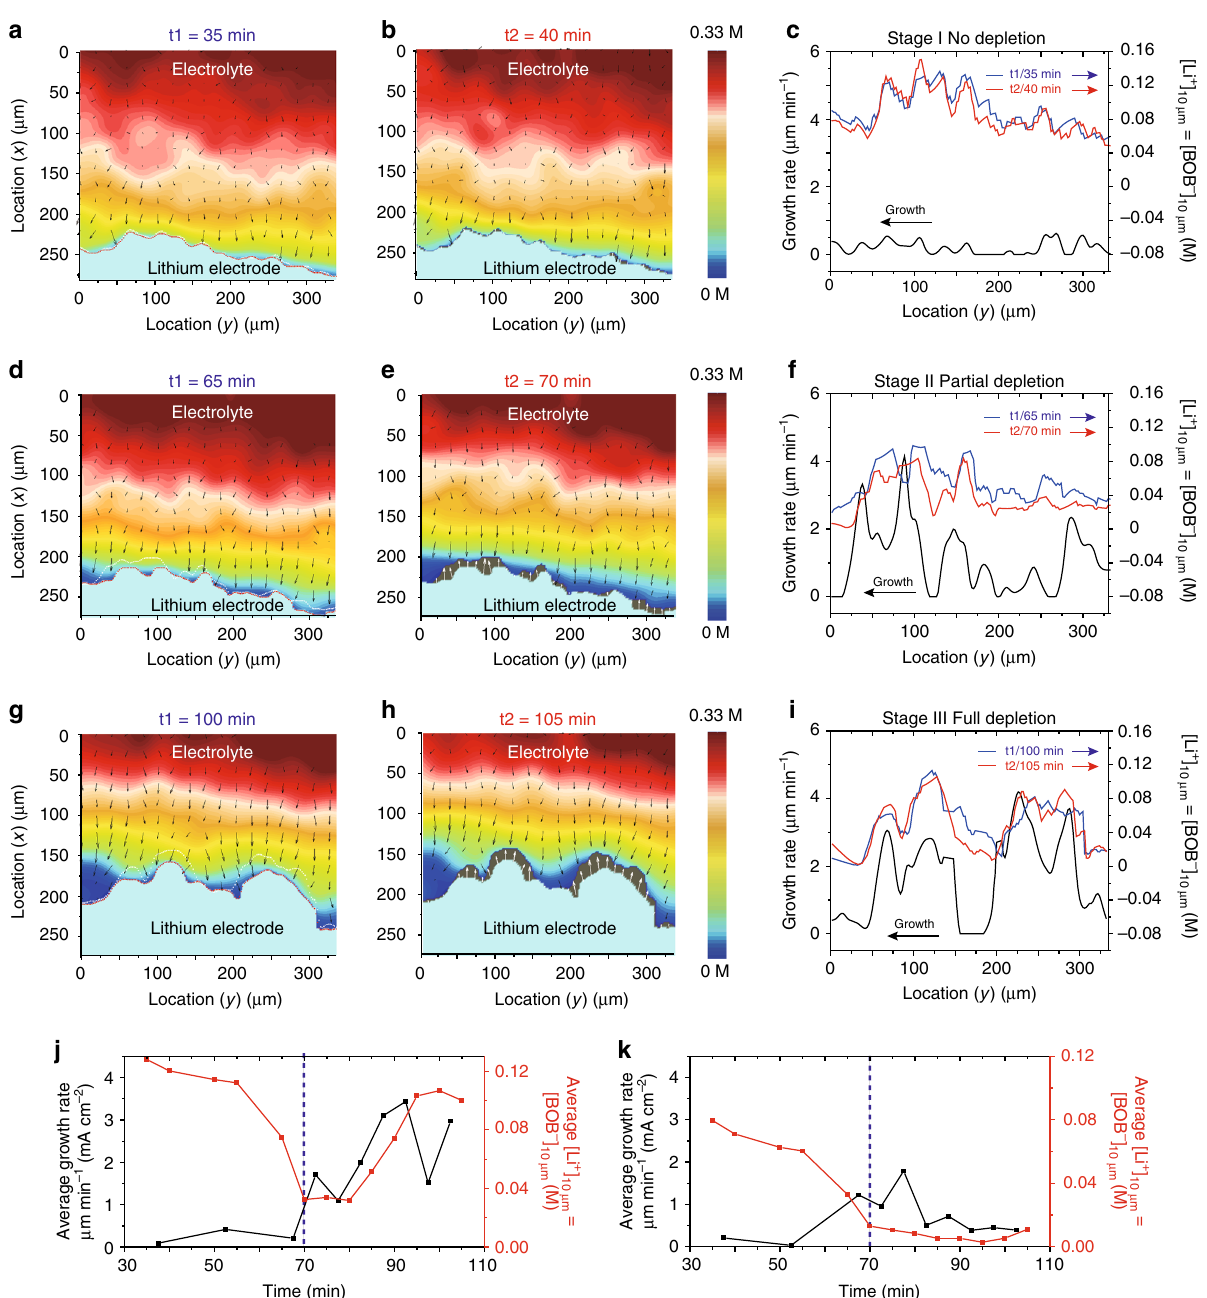
Fig. 4 Correlation between local Li growth and local Li + concentration. 2D overlapping images at three representative moments (t1/t2), a – c 35/40 min (stage I / no depletion), d – f 65/70 min (stage II / partial depletion), and g – i 100/105min (stage III / full depletion). The fi rst column exhibits the ionic concentration pro fi le and solid Li electrode region at t1. The boundaries of the lithium electrode at t1 and t2 are labeled by red and white dash lines, respectively. The second column exhibits the [Li + ] at t2. The gray region at the bottom shows the difference in the solid Li electrode between t1 and t2. The white arrows represent the dendrite growth direction and rate. The [Li + ] in the electrolyte is represented by a jet color bar. The arrows in the electrolyte represent the concentration gradient in the electrolyte. Kernel smoothing was applied in a – f to reduce the noise to <10 mM (See “ Methods ” section and Supplementary Fig. 9). The third column ( c , f , i ) shows the relationship between the dendrite growth rate (black lines) and [Li + ] 10 μ m vs. the location at t1 (blue lines) and t2 (red lines). The corresponding scattering plots are presented in Supplementary Fig. 15. j , k The relationship between the Li growth rate and [Li + ] 10 μ m in two regions: fast growth region ( j : location ( y ) 112 – 132 μ m) and slow growth region. ( k : location ( y ) 0 – 40 μ m). Blue dashed line is at 70 min when depletion starts. All [Li + ] values in this study are measured based on [BOB – ], and their difference should be less than 0.1 mM, which is much smaller than the SRS resolution in the